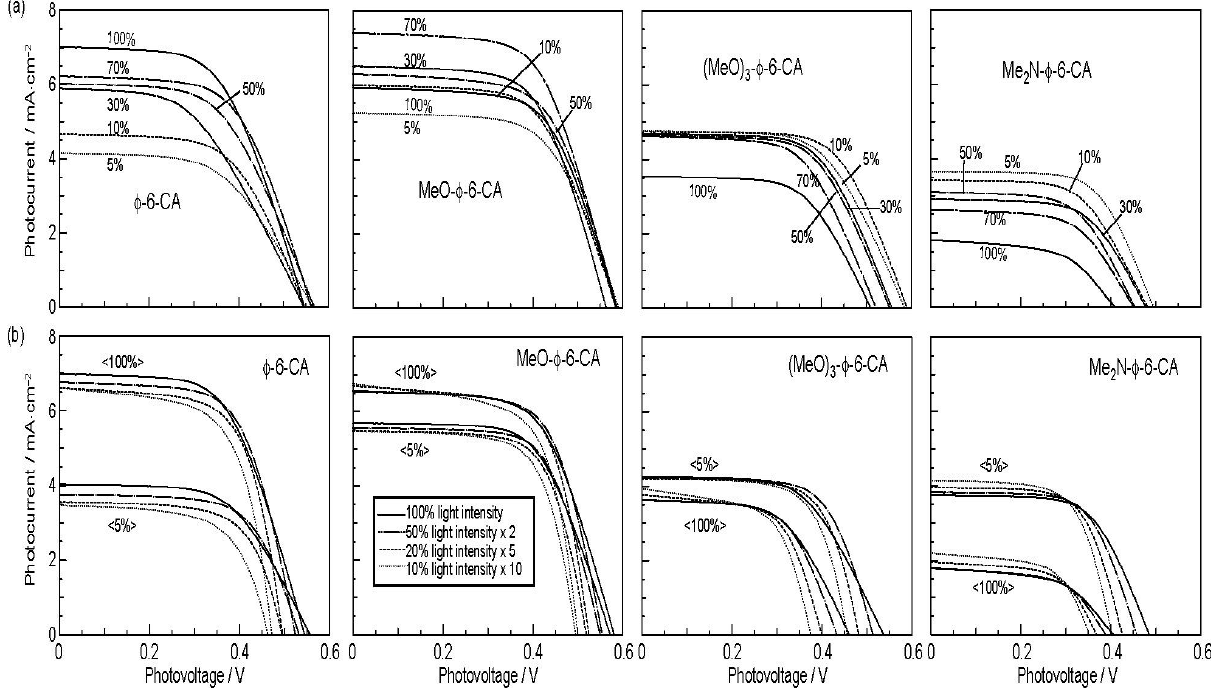
Figure 13. ( a ) The concentration dependence and ( b ) the light-intensity dependence (at two different concentrations) of the I–V curves in solar cells using the four sensitizers having different polarizabilities (see Figure 12) (reprinted from [8] with permission of